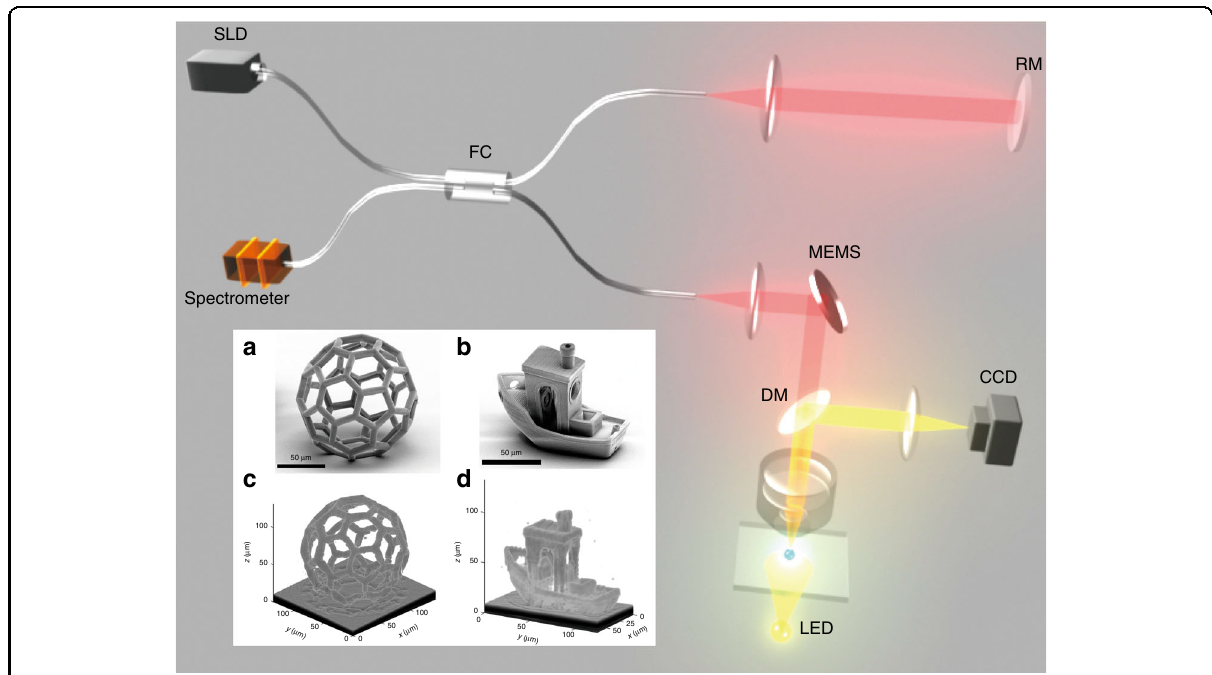
Fig. 1 Experimental concept of FD-OCT. Inset: SEM ( a , b ) and reconstructed images by FD-OCT ( c , d ) of laser-printed 3D